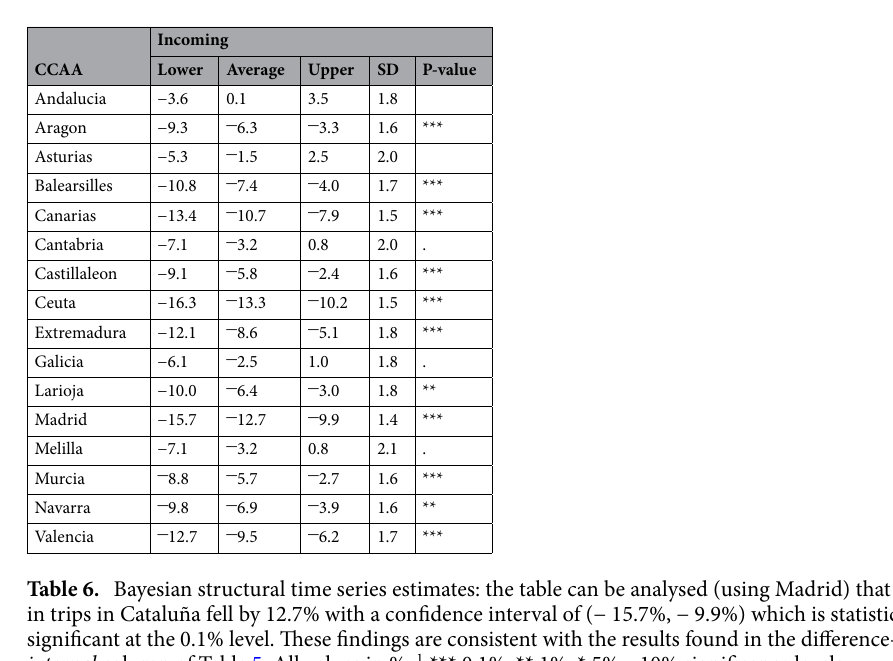
where t o corresponds to the mobility data for each corresponding weekday at the beginning of October. Next, we compute the Pearson correlation coefficients with a 95% confidence interval for lags 1:40 as shown in Fig. 10. We finally take the optimal lag of 21 and plot the scatter-plot between the growth rate ratio defined in Eq. (5) and the normalised mobility defined in Eq. (6). The results can be seen in Fig. 11. There is an association between increased mobility and an increase in the growth rate ratio.